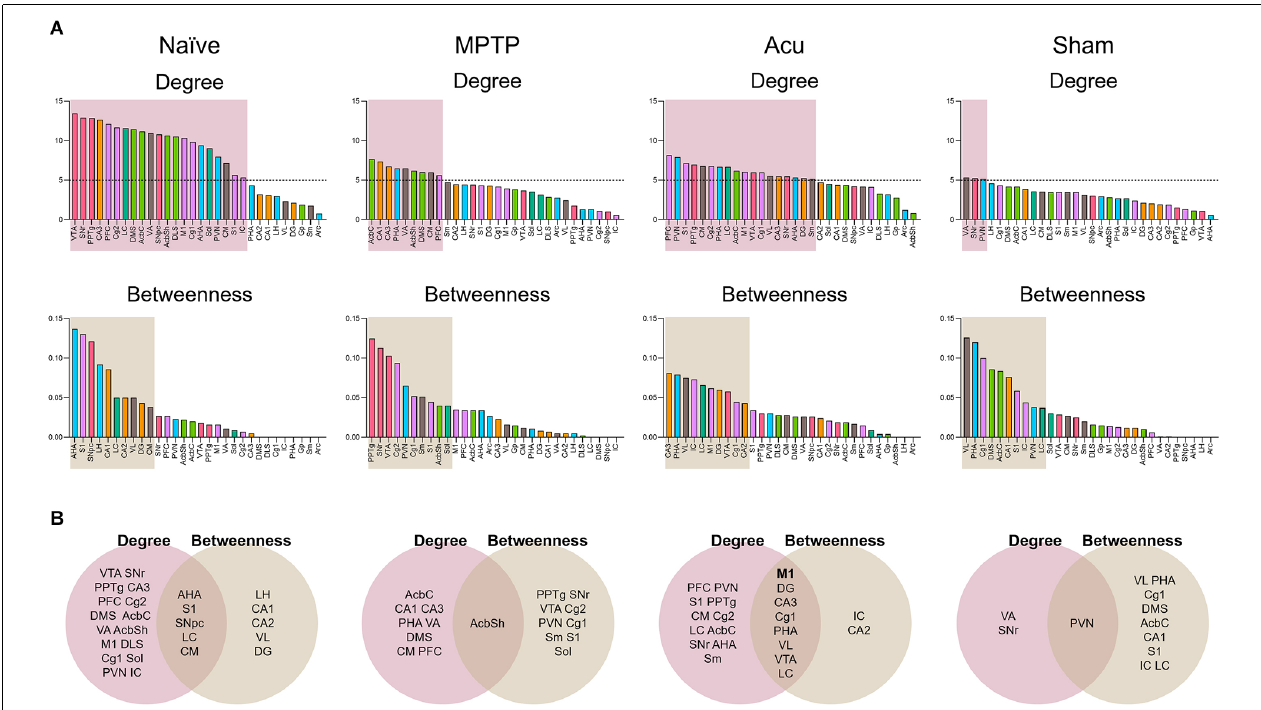
FIGURE 3 | Hub identification of 30 brain regions. (A) Brain regions were ranked in descending order for degree and betweenness centrality. Boxes indicated brain regions ranked by a score of 5 or greater for degree and above the 33rd percentile for betweenness. (B) The Venn diagram shows the overlap between brain regions ranked for degree and betweenness